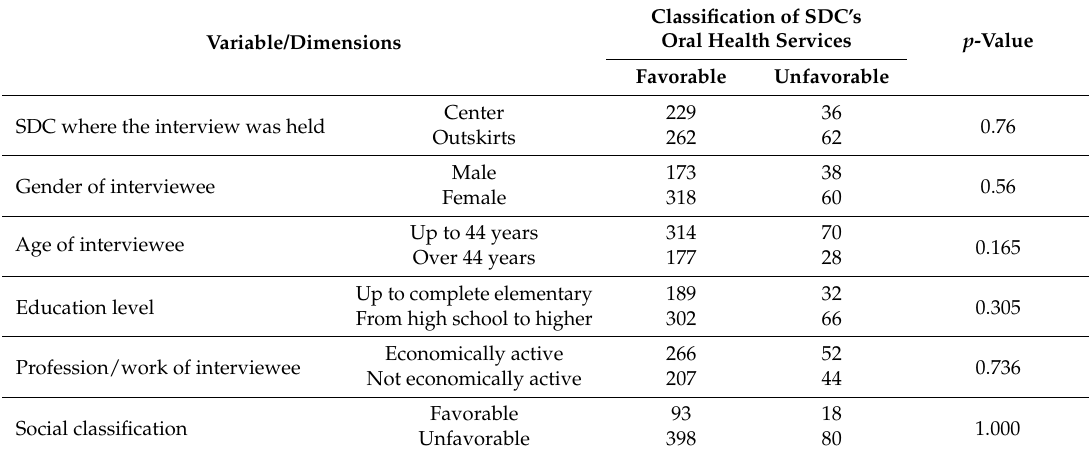
Table 2. Bivariate analysis (Fisher’s exact test) of users’ perceptions in relation to oral health services of the Specialized Dental Clinics (SDC) and sociodemographic variables ( n = 589).